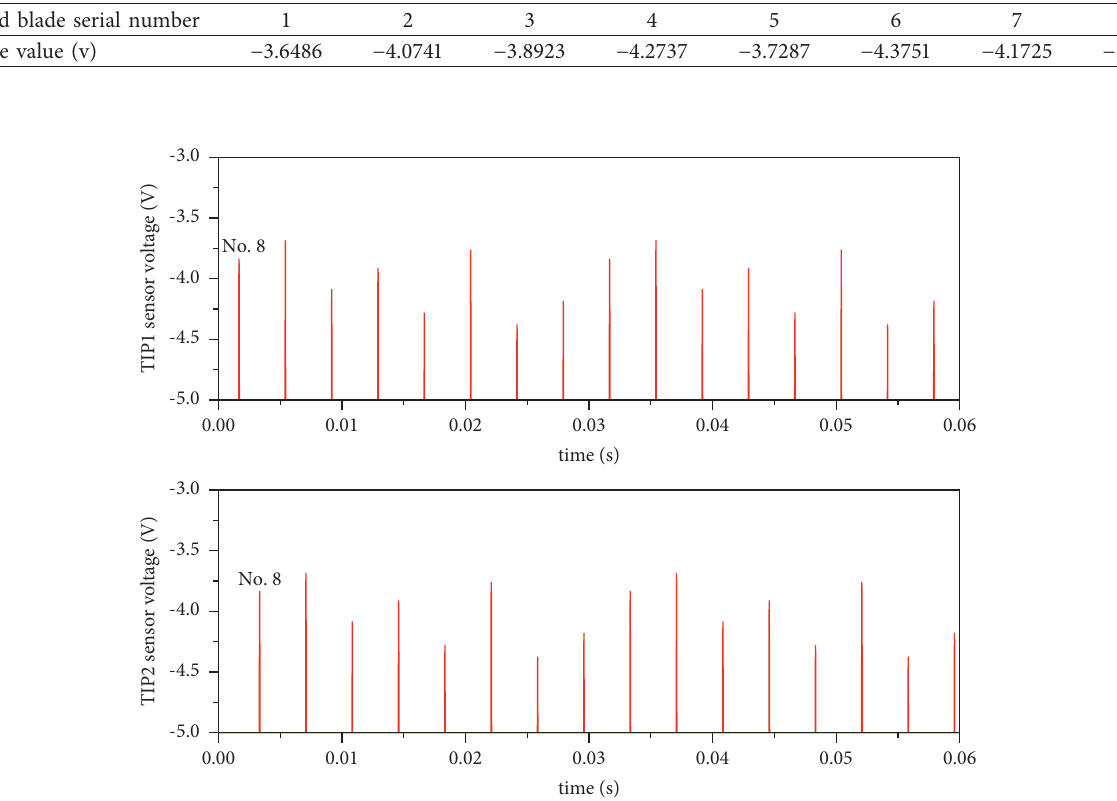
Figure 6: Measurement result of blade tip-timing sensors.